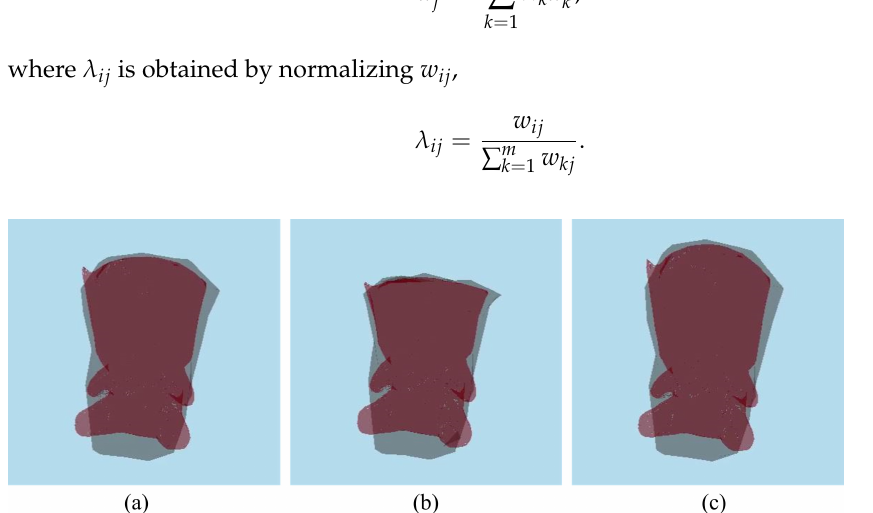
Figure 8. Deformation of a high-resolution model (red) enclosed by a low-resolution model (gray): ( a ) initial, ( b ) pushed, and ( c ) pulled